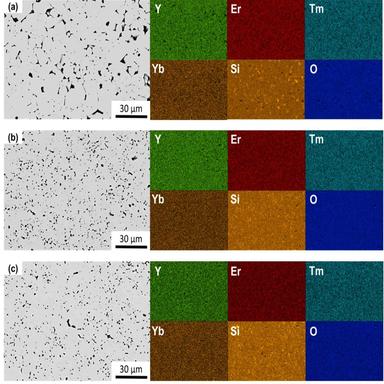
SEM images and corresponding EDS mapping analyses of polished surfaces of bulk (Y0,25Er0,25Tm0,25Yb0,25)2Si2O7 at 1600 ℃ for (a) 12, (b) 18, and (c) 24 h.